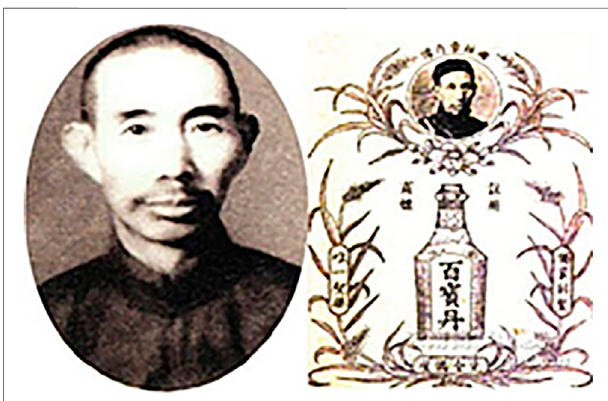
FIGURE1| Huan-zhang Quand the brand ofYunnan Baiyaoduringlate Qing Dynasty (1840 – 1912) and the Republic of China (1912 – 1949).